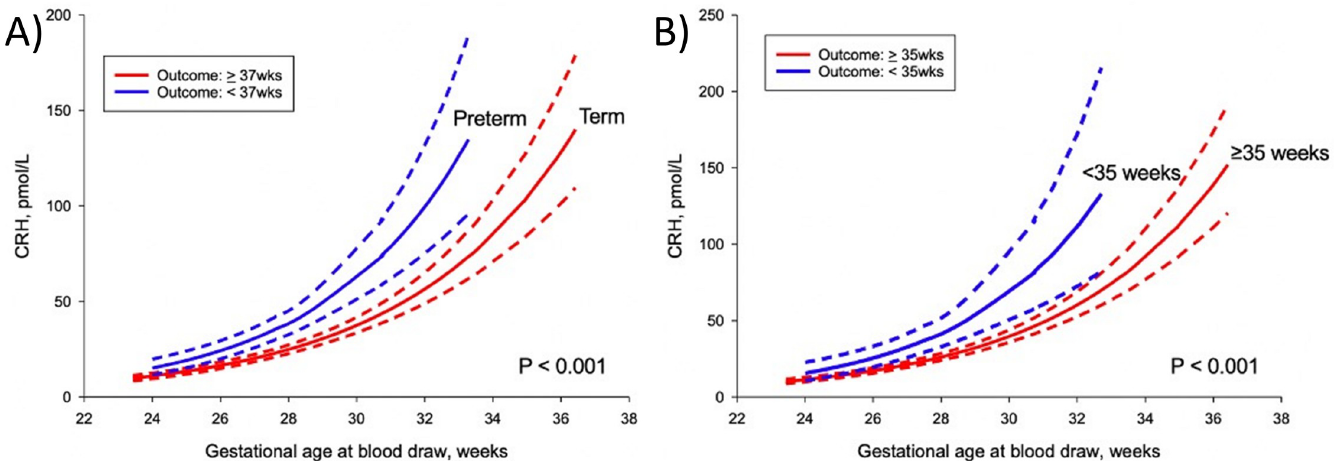
Fig 4. Maternal plasma corticotrophin-releasing hormone level as a function of gestational age based on delivery outcome: (A) < 37 weeks (blue line) versus � 37 weeks (red line); (B) < 35 weeks (blue line) versus � 35 weeks (red line). Dotted lines represent 95% confidence intervals.